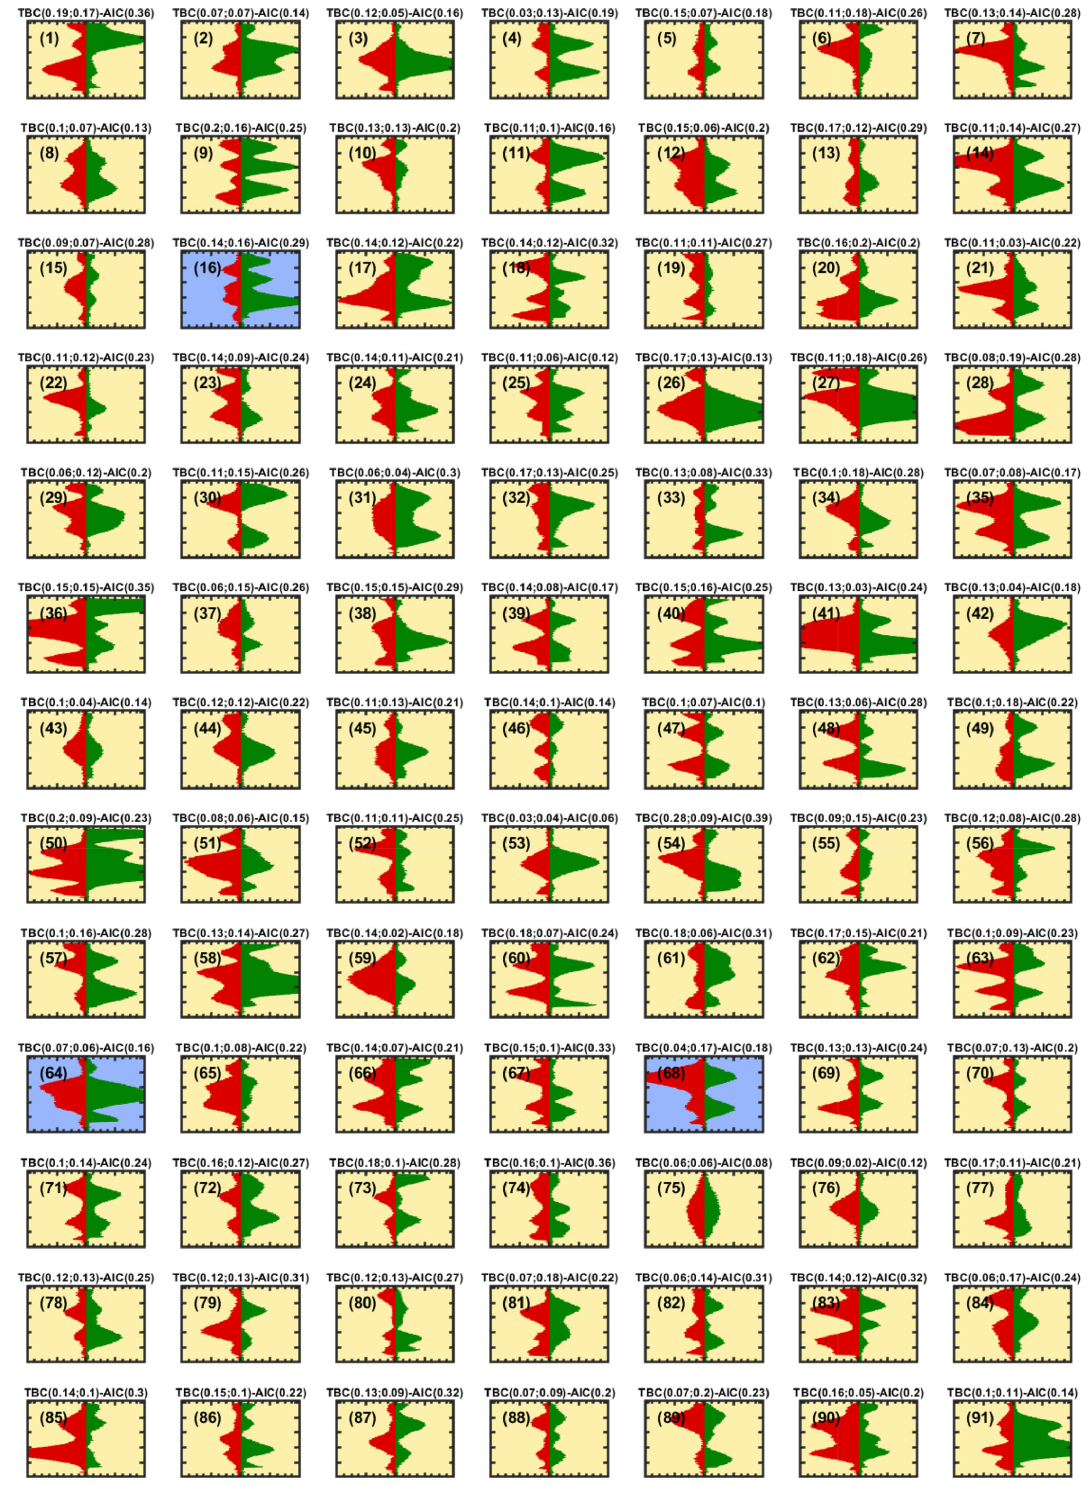
Figure 9. As in Fig. 8 but for particles imaged with PPD-HS during period 2 of the experiment shown in Fig. 7.